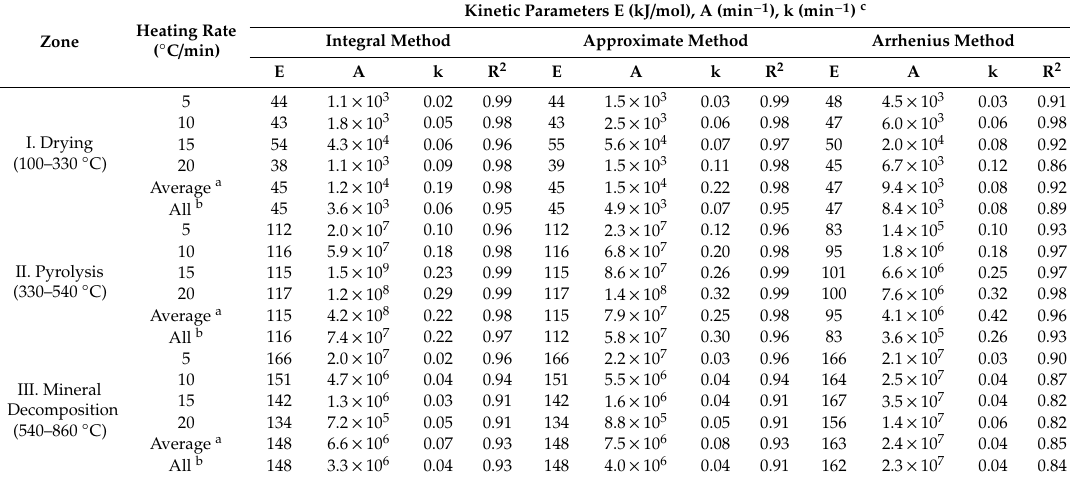
Table 4. E ff ect of heating rate on the apparent kinetic parameters and the rate constant at the average zone temperatures for the three kinetic